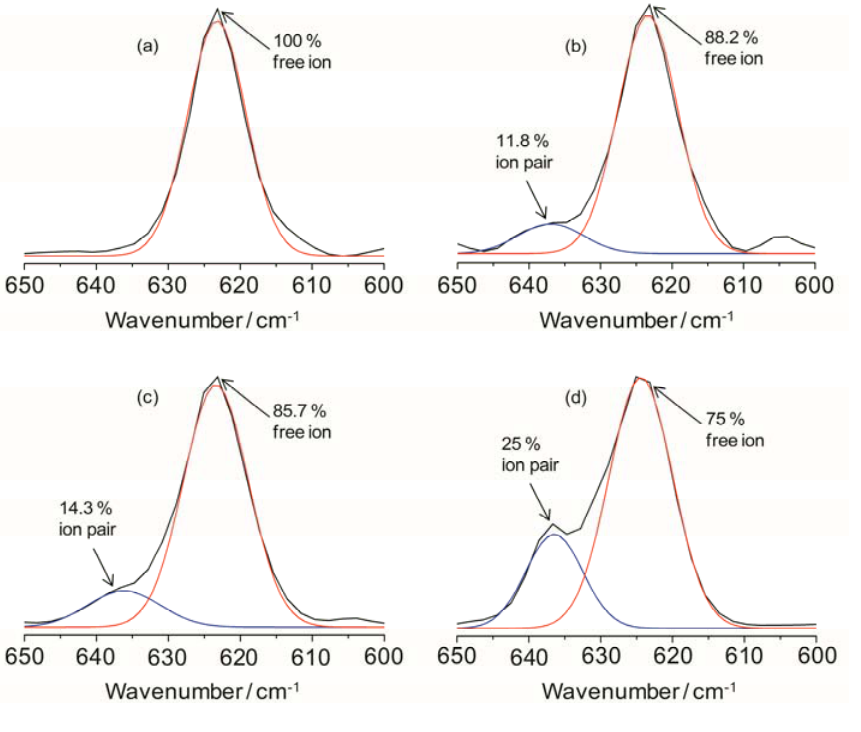
Figure 3. IR deconvolution results (in the range of 600 to 650 cm − 1 ) of TIE(2000)-Z hybrid electrolytes with various [O]/[Li] ratios, where Z = ( a ) 32; ( b ) 24; ( c ) 16 and ( d )